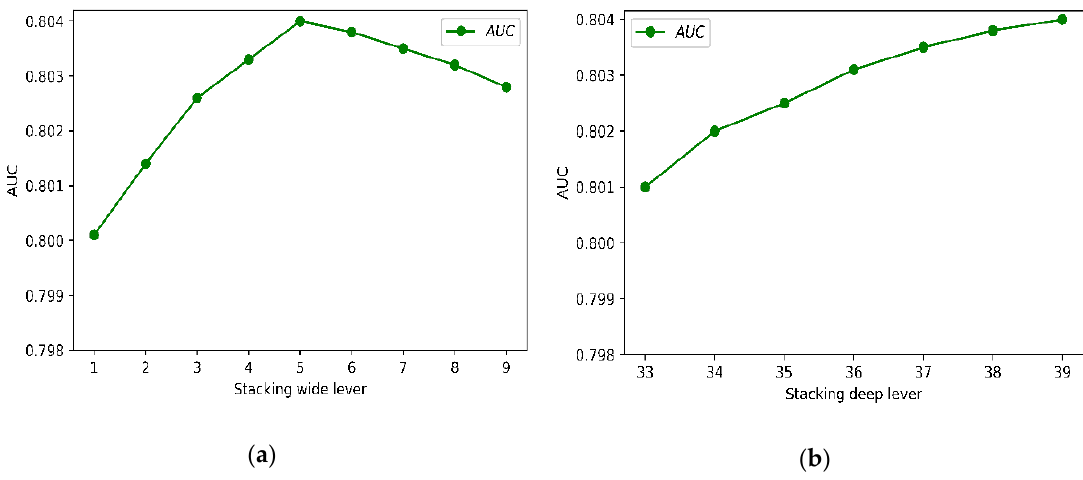
deep Figure 3. ( a ) Description of effects of stacking width lever; ( b ) description of effects of stacking deep lever.